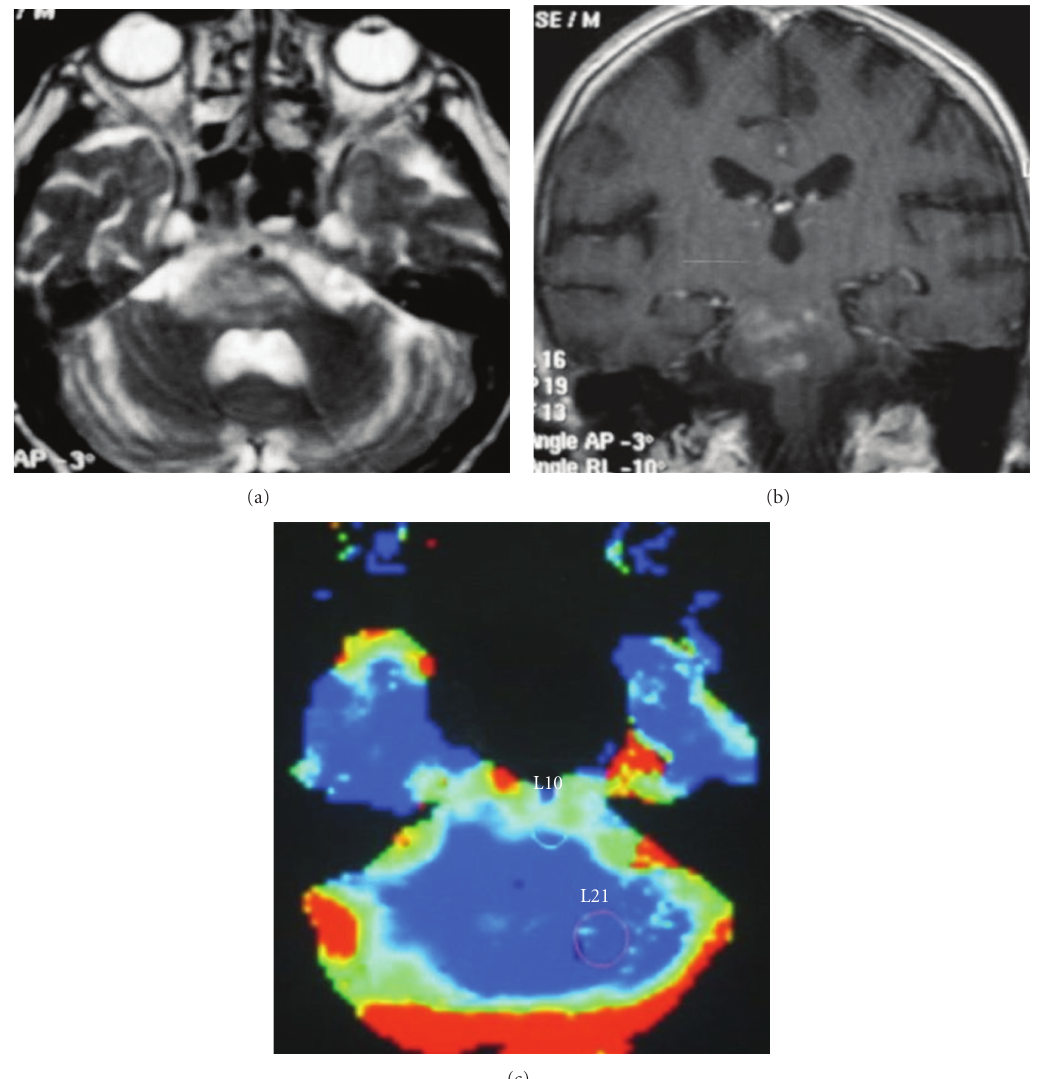
Figure 1: A female patient with neuro-Behcet’s disease. (a) T2-weighted fast spin-echo axial MR image shows patchy hyperintensities in pons. (b) Contrast-enhanced T1-weighted echo axial MR image demonstrates nodular enhancement in pons. (c) ROIs (regions of interest) were placed into pons and cerebellar white matter in perfusion